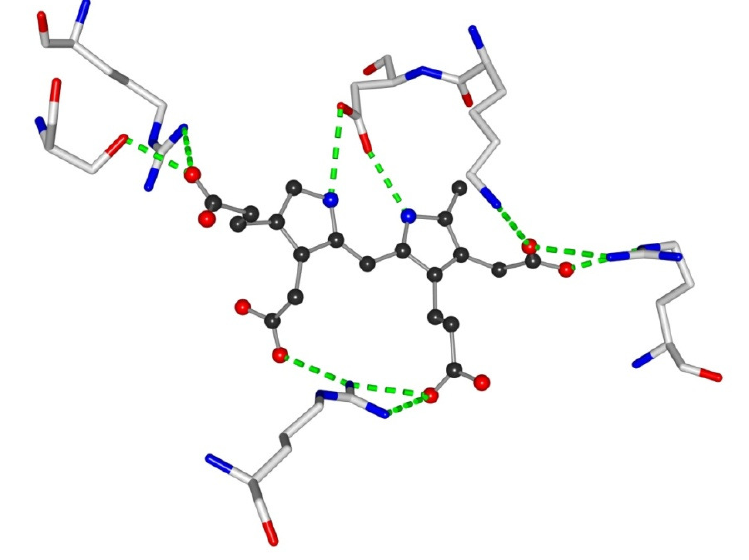
Figure 1. Partial view of the X-ray structure of the enzyme porpho-bilinogen de-aminase complex showing the binding of the di-pyrromethane co-factor through pyrrolic NH to Asp 84 and carboxylic side chains with Arg 155 and Lys